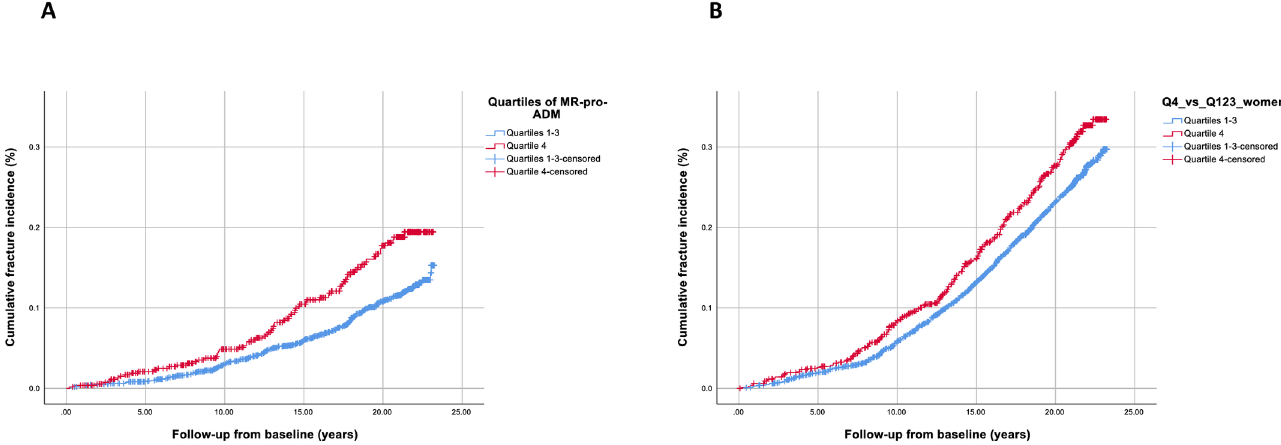
Fig 1. Kaplan-Meier curves for incident fragility fractures among men (A) and women (B) stratified into highest quartile vs lower quartiles of mid- regional-pro-adrenomedullin plasma levels at baseline. 4 th Quartile among men and women corresponded to (cid:21) 0.51 pm/L and (cid:21) 0.54 pm/L respectively.